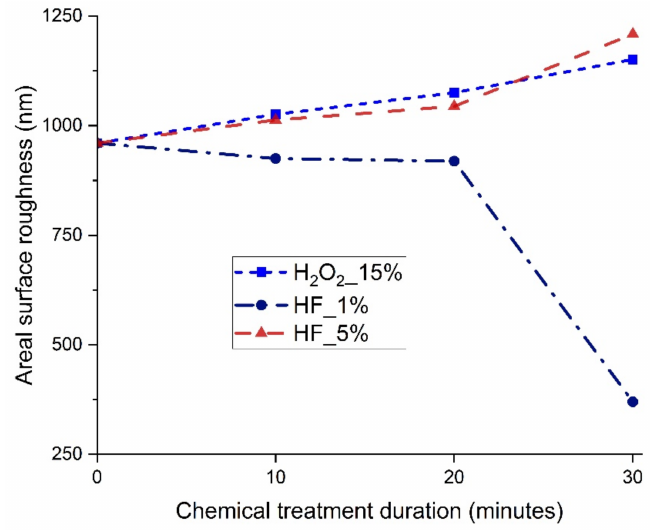
Figure 13. Areal surface roughness of chemically treated surfaces.